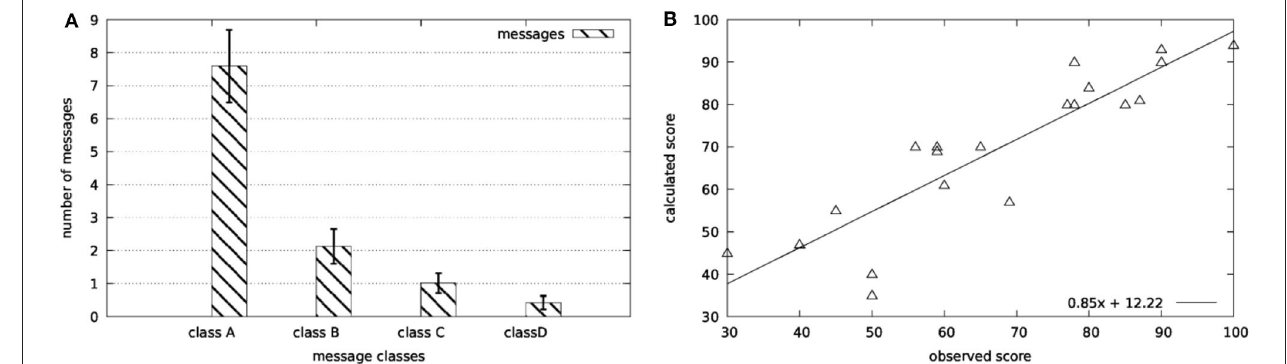
FIGURE 11 | Validation results for the scoring functions: (A) Online scoring and (B) offline